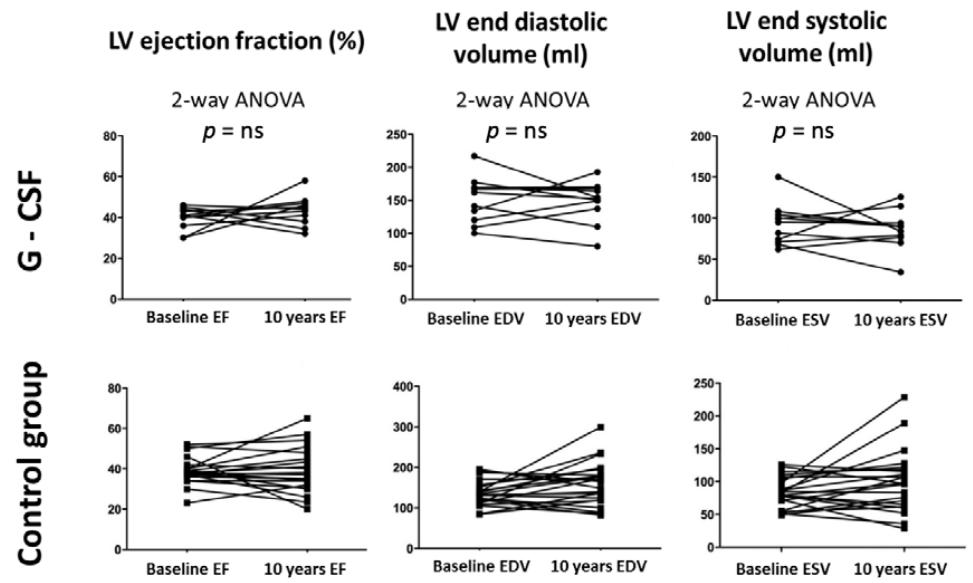
Figure 2. Echocardiographic parameters of patients receiving G-CSF and control group at 10-year follow-up. From left to right: left ventricular ejection fraction (LVEF), left ventricular end-diastolic volume (LVEDV) and left ventricular end-systolic volume (LVESV). Two-way ANOVA analysis was performed. NS=non-significant result.